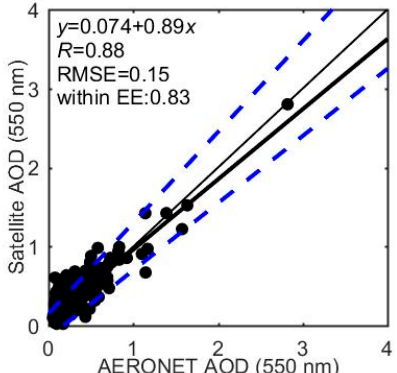
Figure 16. The AVHRR AOD retrieval at 0.55 µ m versus the AERONET AOD measurement at 0.55 µ m. The narrow solid line is the 1:1 line. The bold solid line depicts the regressed line. The error lines ( ± 0.15 ± 0.15 τ ) are also shown (dashed blue lines). The text describes the linear regression relationship, R , RMSE error, and ratio within the error lines.